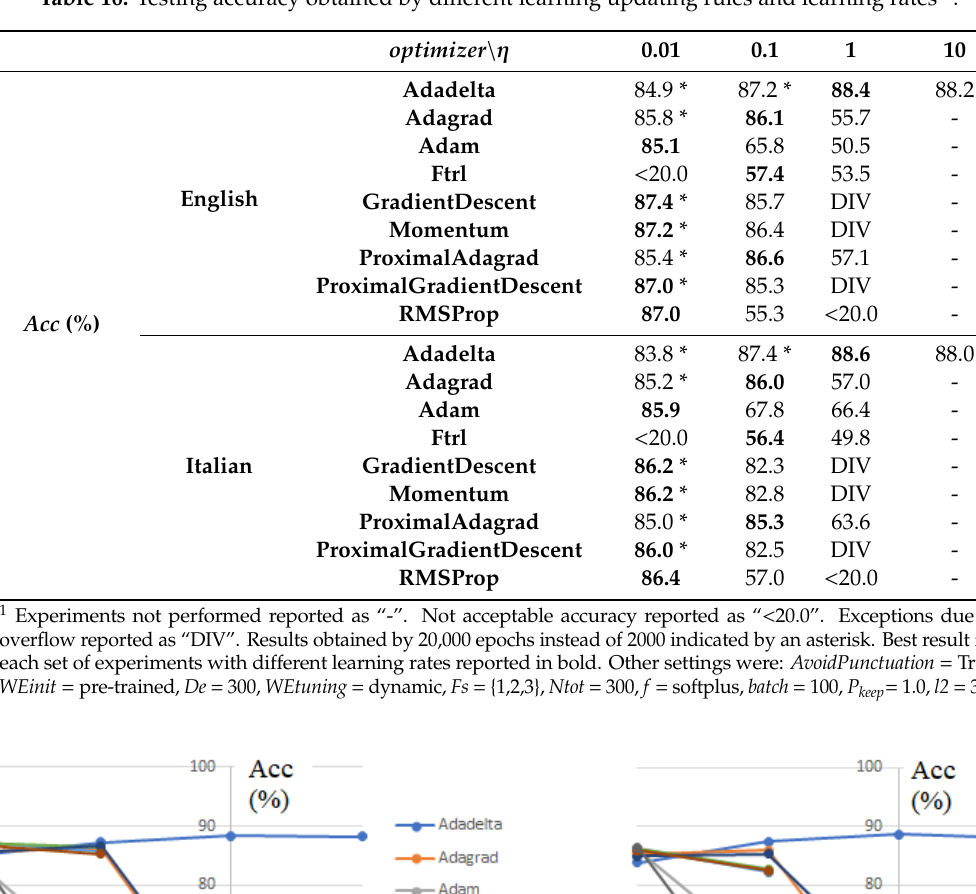
Table 16. Testing accuracy obtained by di ff erent learning updating rules and learning rates 1 .